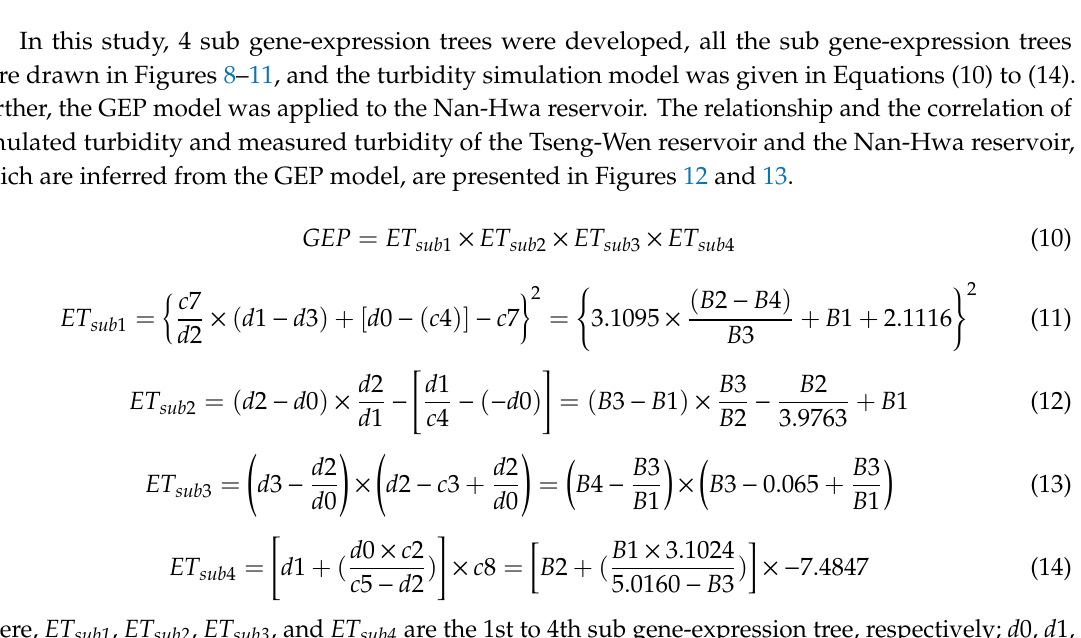
Figure 7. The correlation relationship between observed turbidity and multiple linear regression (MLR) simulated turbidity in Tseng-Wen and Nan-Hwa reservoir.